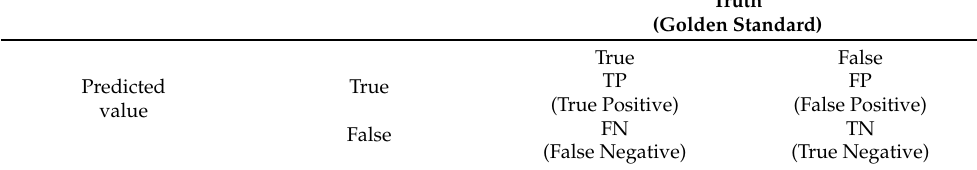
Table 4. Confusion